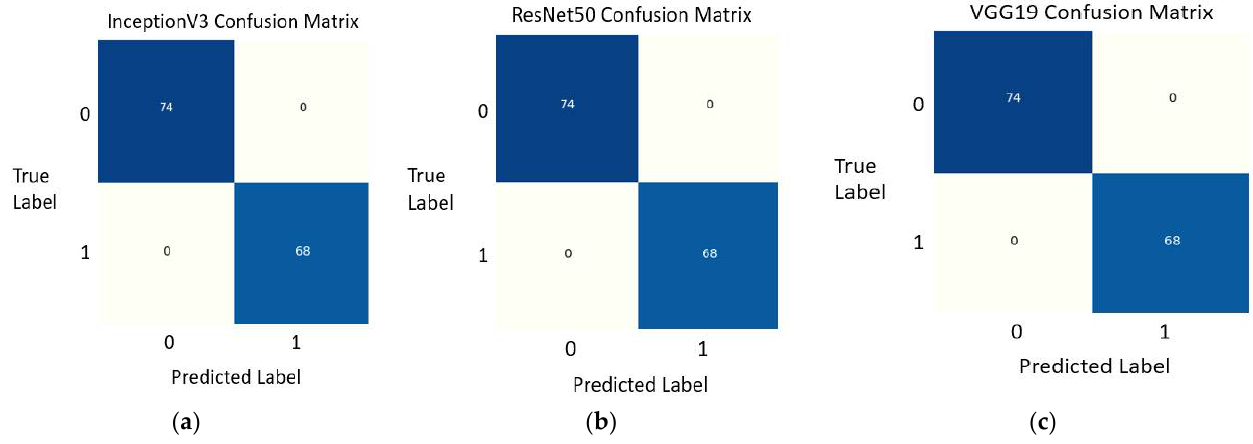
Figure 7. Two-class classifier confusion matrix; ( a ) Confusion matrix of Inception V3 model; ( b ) Confusion matrix of ResNet50 model; ( c ) Confusion matrix of VGG19 model.